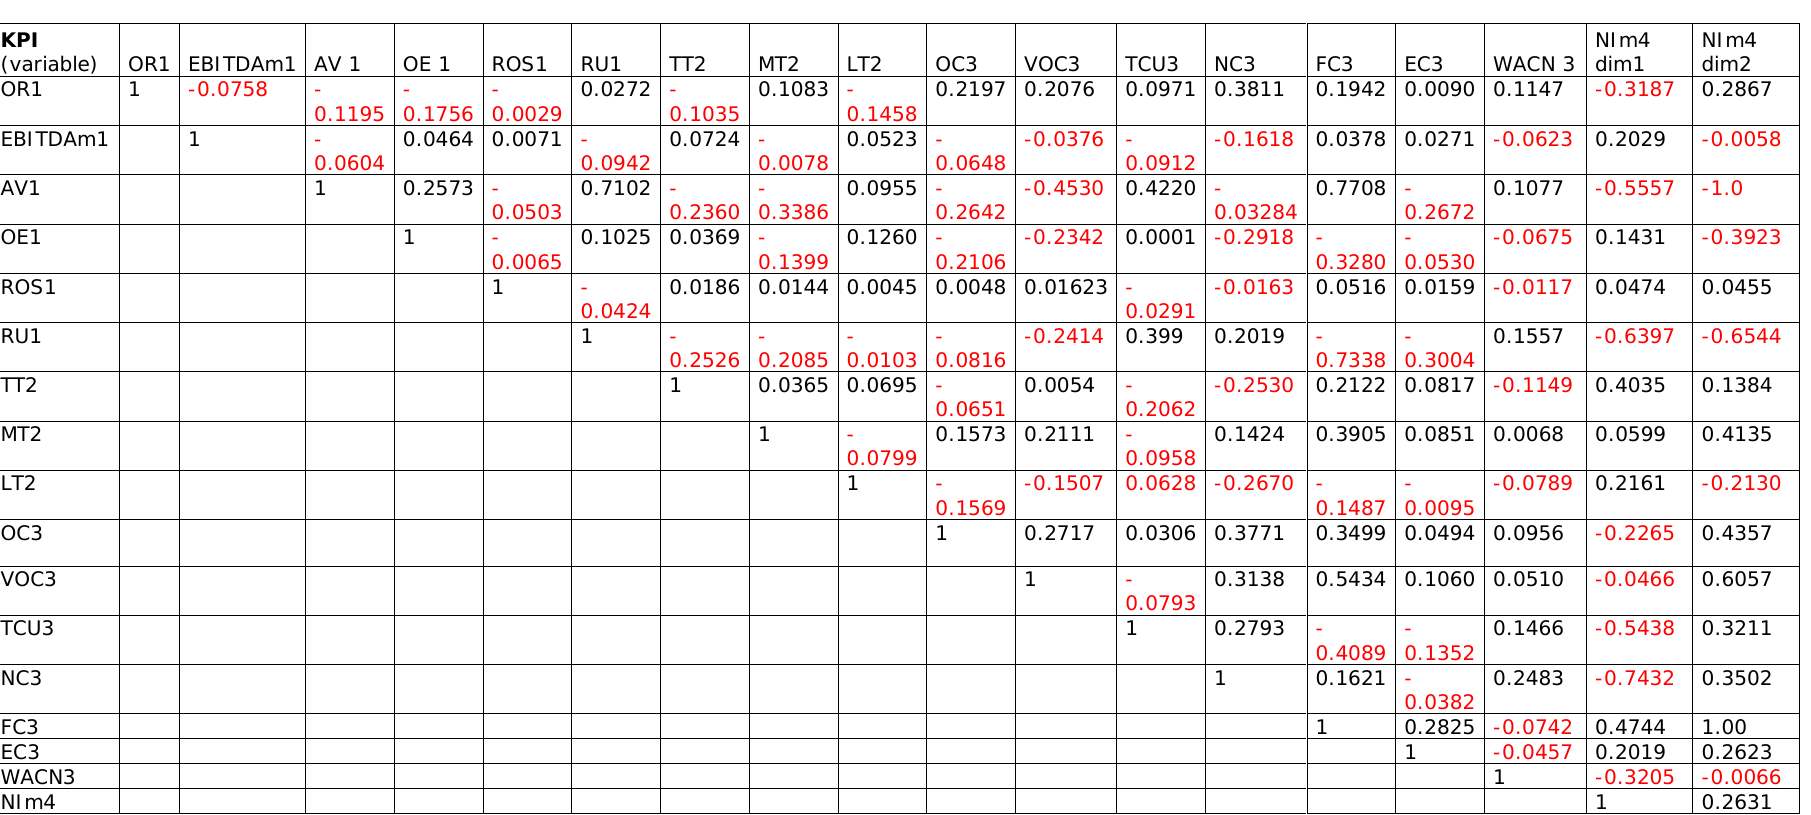
Table 6. “Correlation Matrix 2007 (Ordinal & Multiple Nominal), Note: Abbreviations for variables are explained in Table